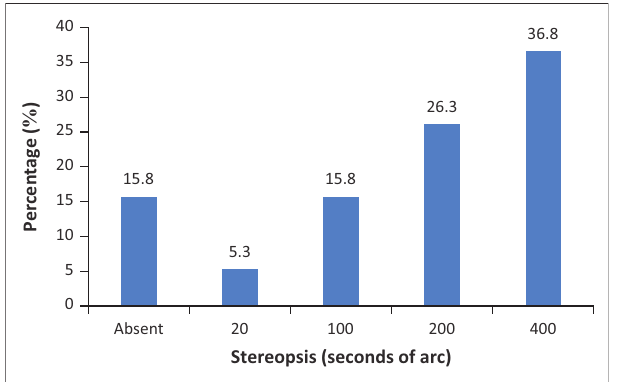
FIGURE 5: Stereopsis findings.